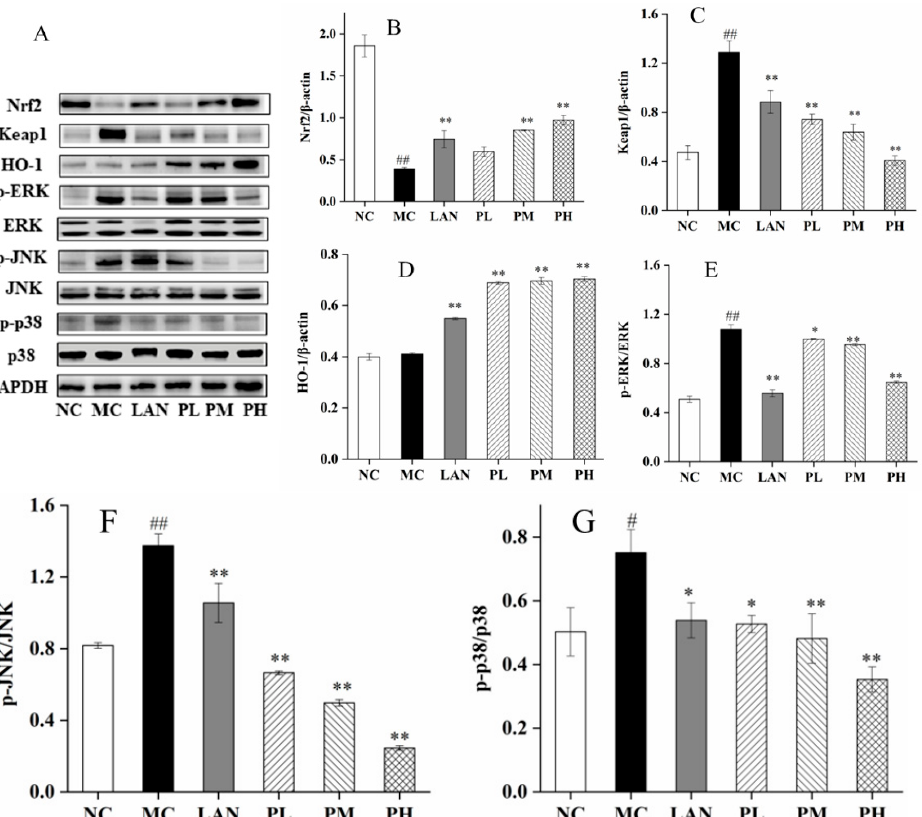
Figure 6. Piperine inhibited ethanol-induced oxidative effects through Nrf2/ HO-1 and MAPK pathways in the gastric tissue of the rats. ( A ) The protein levels of Nrf2, HO-1, Keap1, p -ERK, ERK, p -JNK, JNK, p -p38 and p38 were measured by Western blot. The relative levels of ( B ) Nrf2, ( C ) Keap1, ( D ) HO-1, ( E ) p -ERK/ERK, ( F ) p -JNK/JNK, ( G ) p -p38/p38. Ave ± SD, # p < 0.05, ## p < 0.01 vs. NC group; * p < 0.05 and * * p < 0.01 vs. MC group.